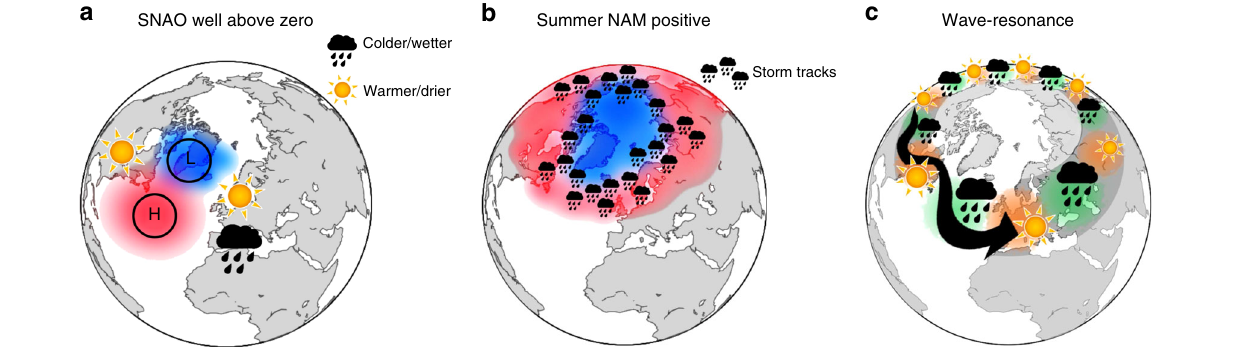
Figure Box 2: Panel a shows a schematic of the positive SNAO indicating the anomalously low (blue) and high (red) sea level pressure regions together with cold/wet and dry/warm regions. Panel b shows a schematic of the 500 hPa geopotential height con fi guration during the positive phase of the NAM. Rainy clouds mark the position of the storm tracks during a strongly positive NAM phase. Panel c shows a schematic of an ampli fi ed wave 7. Green and orange regions show the position of pronounced northward and southward wind anomalies. (Figure created using Python, GIMP, Powerpoint and Inkscape